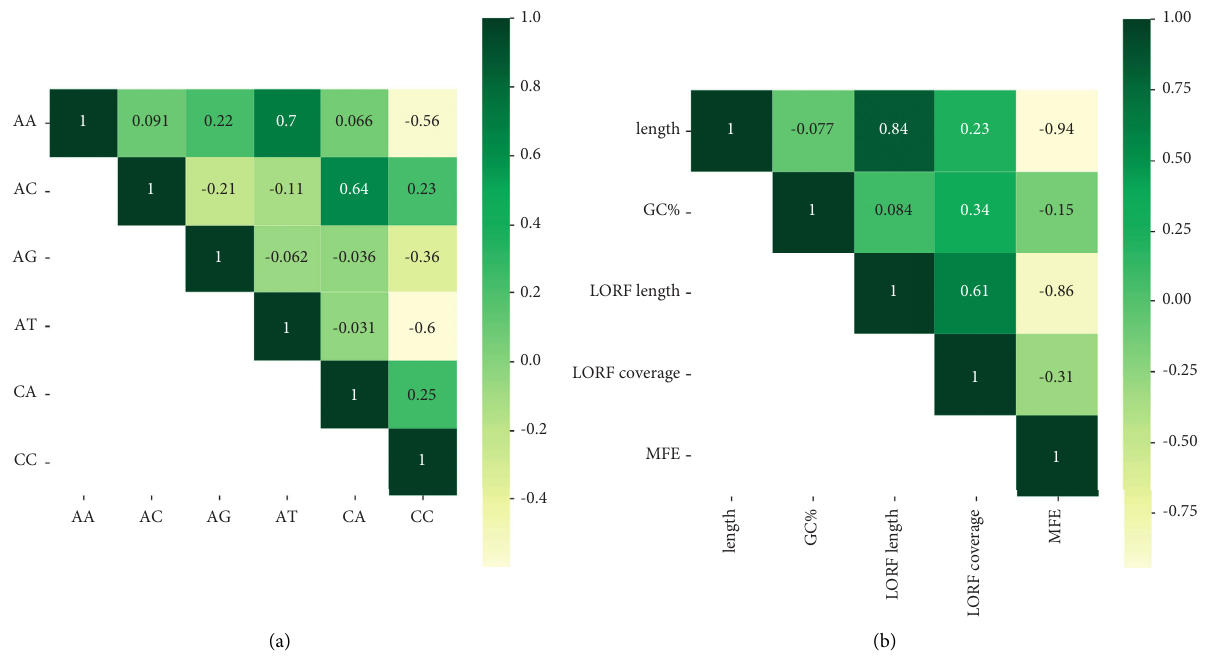
Figure 5: Correlations between the features. The positive numbers indicate a positive correlation between features, the negative numbers indicate a negative correlation, and the larger absolute values indicate a higher